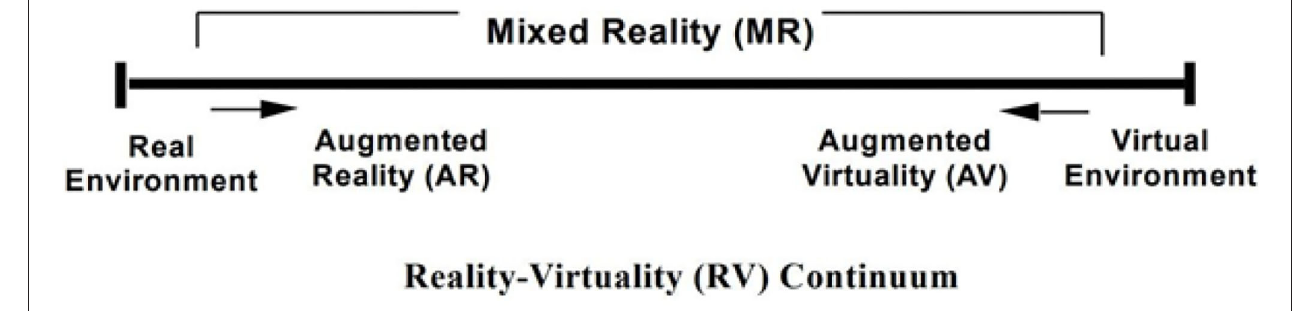
FIGURE 1 | Real-virtual continuity system.